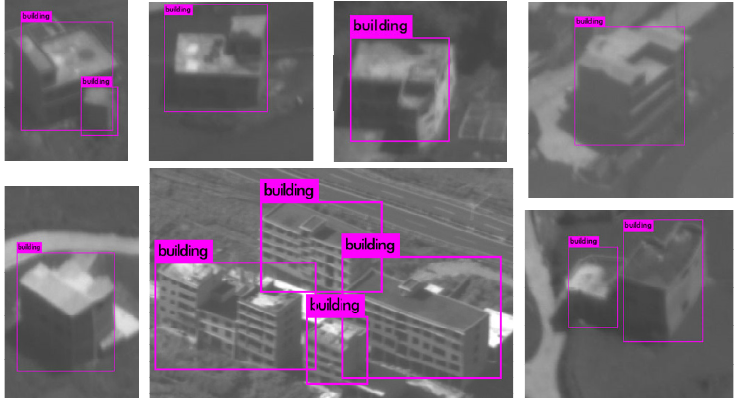
Figure 4. Detection results of small scattered buildings.